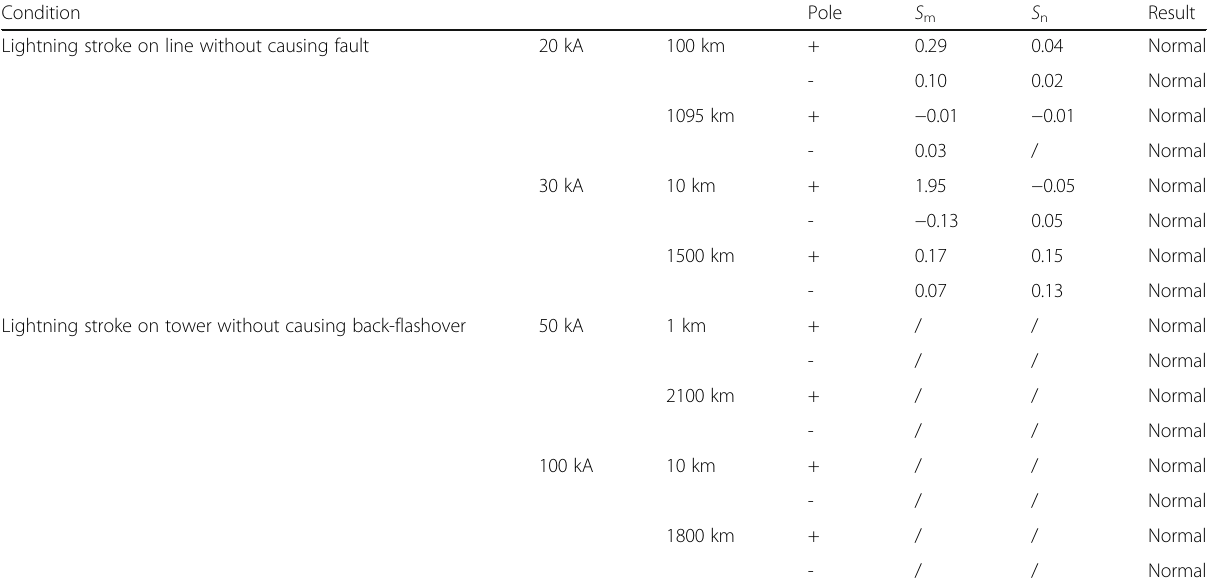
stroke on tower without causing back-flashover, the protec- tion units will not start.